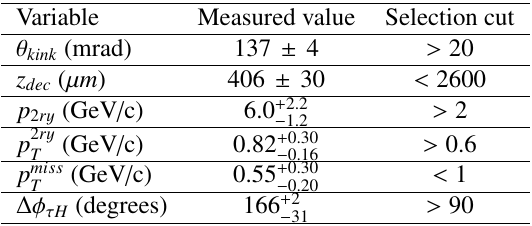
Table 3. Measured values of the kinematical variables used to select candidate events in the τ → 1 h decay channel for the fourth ν τ event and corresponding selection cuts.